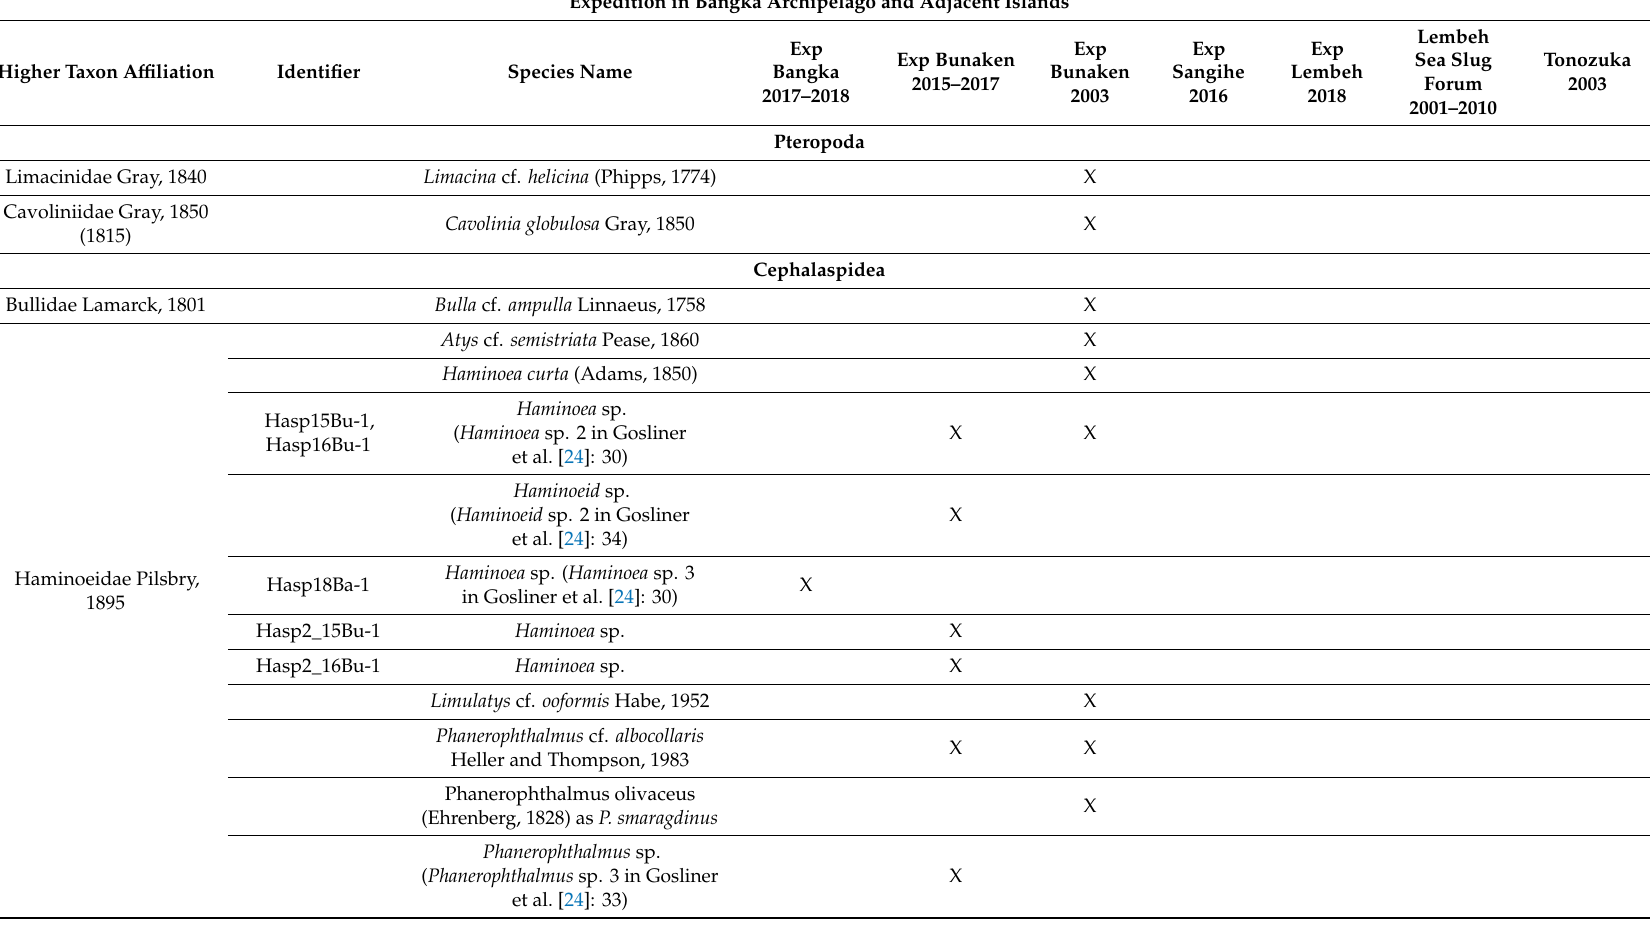
Table 3. Compilation of the species recorded in this study and those recently published from Bunaken National Park [16], a previous study from Bunaken National Park [15], from Sangihe Island [18], and three sources on Lembeh Strait: Ompi et al. (2019) [17], species records from Lembeh Strait available from the seaslugforum.net [21] in the time period of 2001–2010, and data extracted from Tonozuka [39]. (*) indicate species that were identified only by